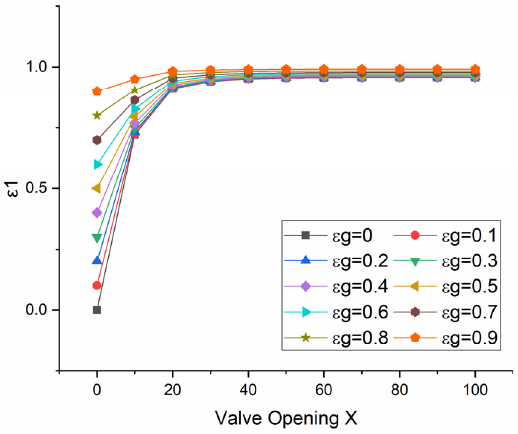
Figure 5. Combined flow characteristic curve of governing valve.